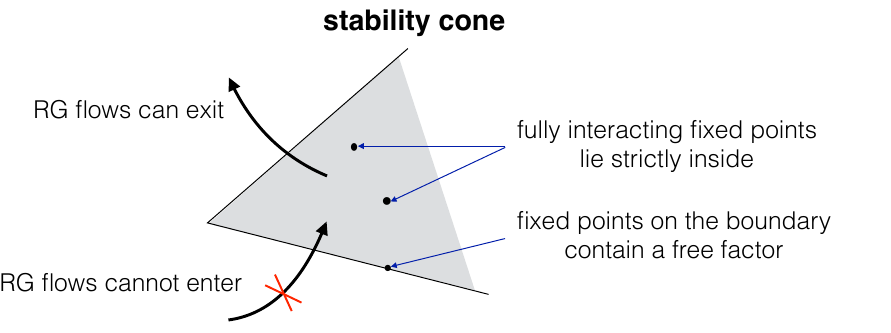
Figure 1: Graphical summary of the results of section